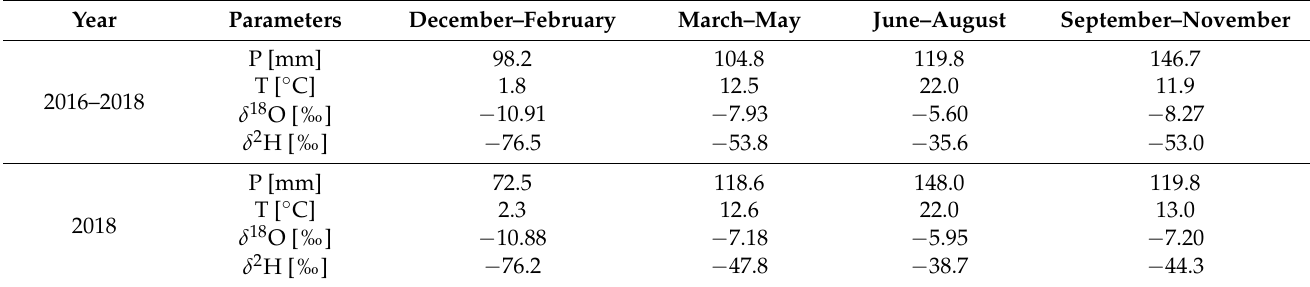
Table 1. Mean precipitation (mm), mean air temperature ( ◦ C), and mean isotope composition of precipitation for the three-month periods during 2016–18 and 2018, respectively.